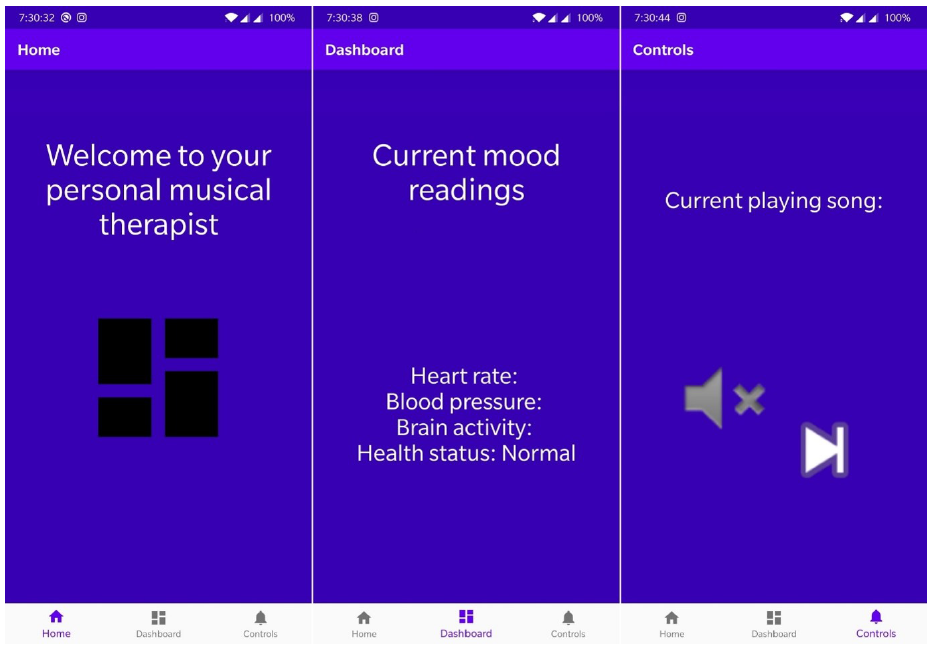
Figure 3. Screens of Android music therapy app.